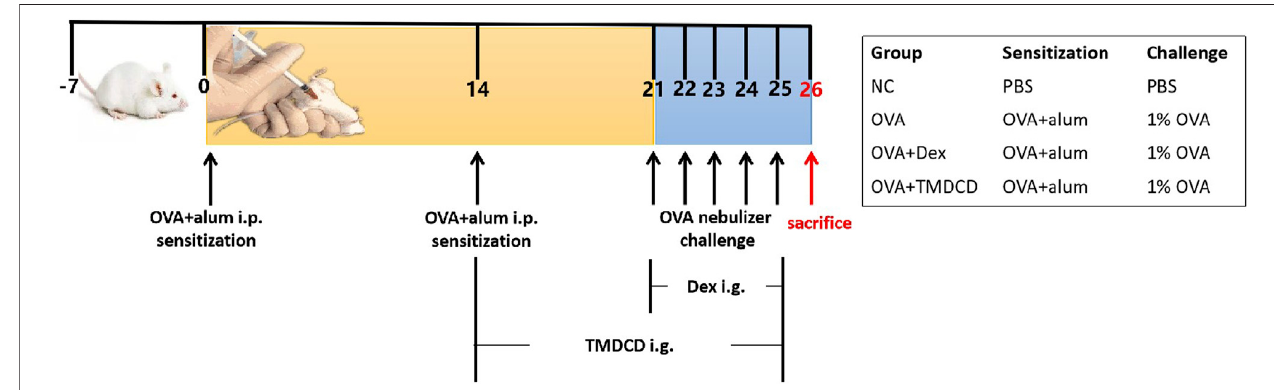
FIGURE1 | Schematic diagram ofallergic asthma model establishment. Sensitization: The mixture of OVA and aluminum hydroxide gel wasgiven toBALB/cmice (i.p.) at day 0 and day 14. Challenge: 1% OVA was given by aerosol inhalation to mice in all the groups except NC group (given PBS, instead) from day 21 to day 25, continuously.Treatment:TheTMDCDgroupmiceweregivenTMDCDbygavageafterday14,altogetherfor12 days.Fromday21today25,1 hbeforeOVAchallenge, gave dexamethasone to the mice in OVA + Dex group by gavage. The mice were sacri fi ced on day